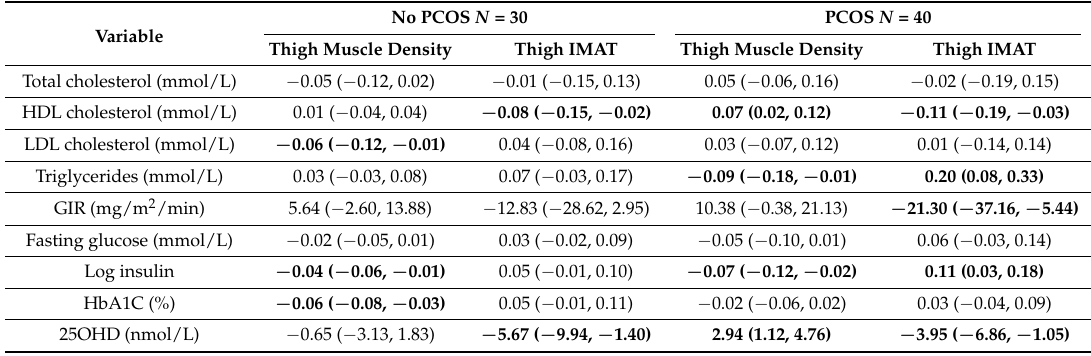
Table 2. Multivariable regression coefficients (95% confidence intervals) for associations of thigh